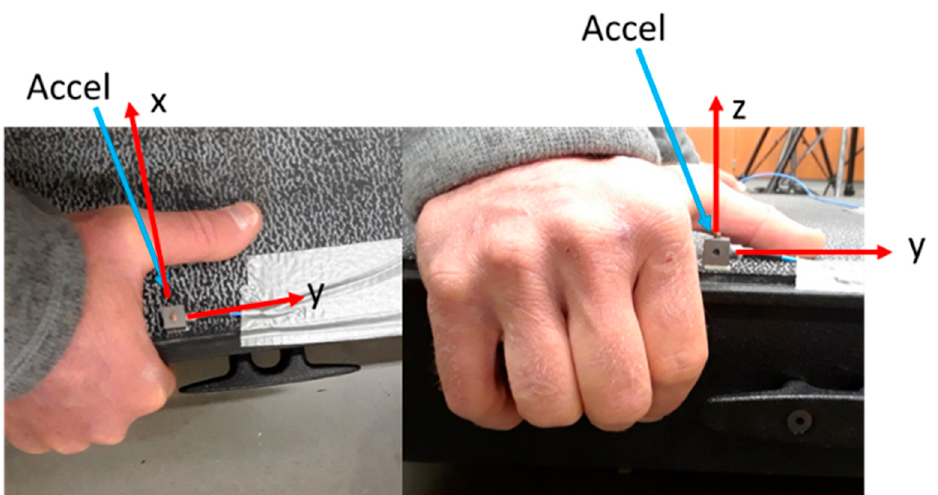
Figure 3. Triaxial accelerometer position on the Vibeplate used to measure the input vibration along all three axes (X, Y, and Z) while loaded with a participant’s body weight in the position used for vibration intervention.